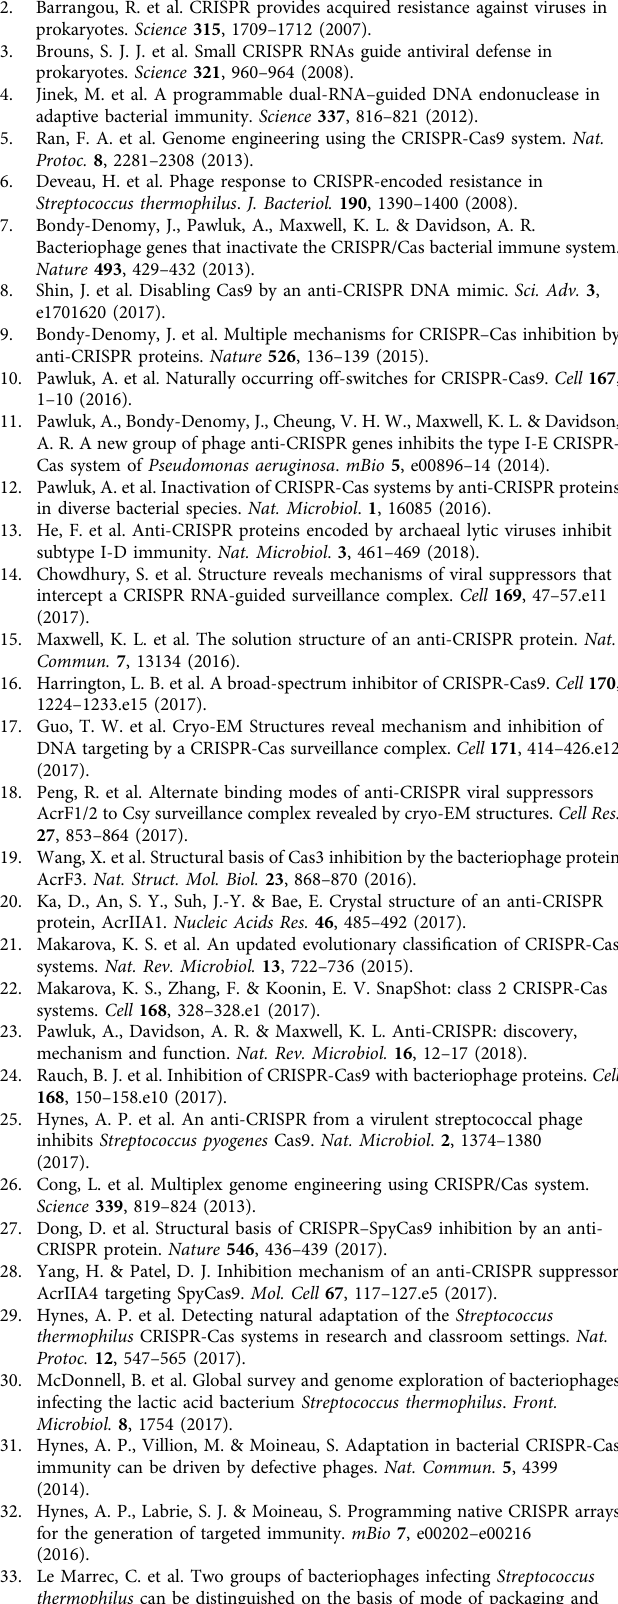
mutation detection kit (Transgenomics) as described 41 . Samples were separated on 10% PAGE gels in TBE buffer. Gels were imaged using a ChemiDoc MP (Bio-Rad) system, and quanti fi cations were performed using the Image lab software (Bio- Rad). Flow cytometry . The frequency of mScarlet-I expressing cells was assessed with a BD LSR II fl ow cytometer. Data availability . Coordinates and structure factors for AcrIIA6 in a cubic native and tetragonal native form have been deposited in the RCSB Protein Data Bank under accession codes 6EYY and 6EYX, respectively. Nucleotide sequences for genomes of phages D5842, D1024, and D1811 have been deposited in GenBank under accession codes MH000602, MH000603, and MH000604, respectively. Other relevant data supporting the fi ndings of the study are available in this article and its Supplementary Information fi les, or from the corresponding author upon